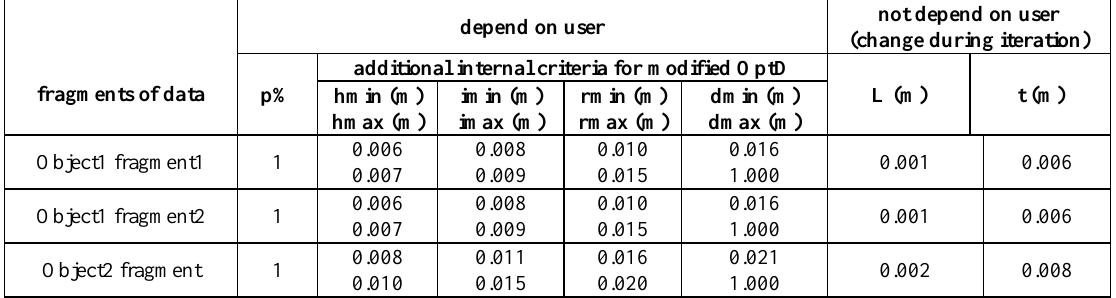
Table 1. Optimization criteria